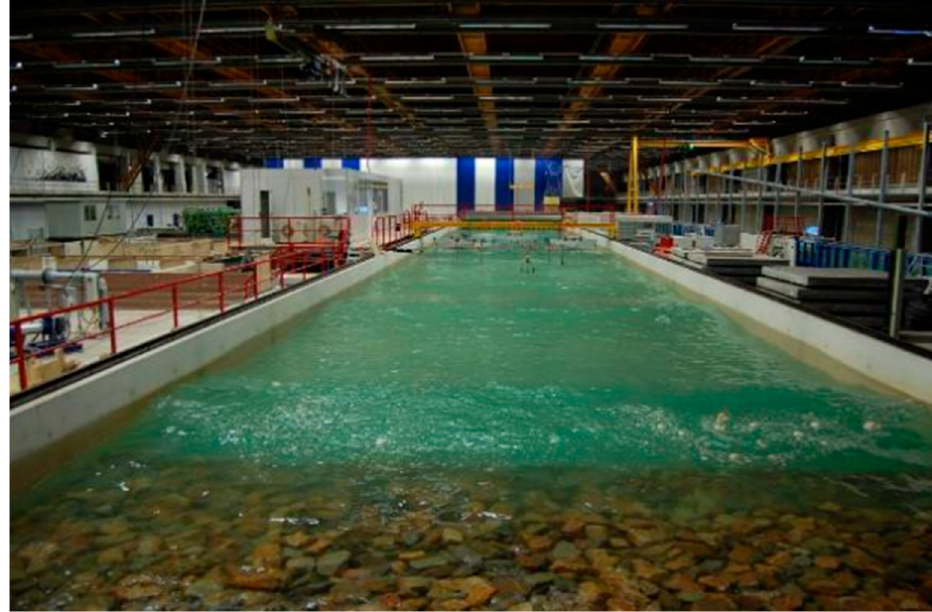
Figure 1. Atlantic Basin (i.e., Deltares’ wide wave-current flume), looking from the wave spending beach towards the test section in the middle of the basin and the wave paddles at the end of the basin.